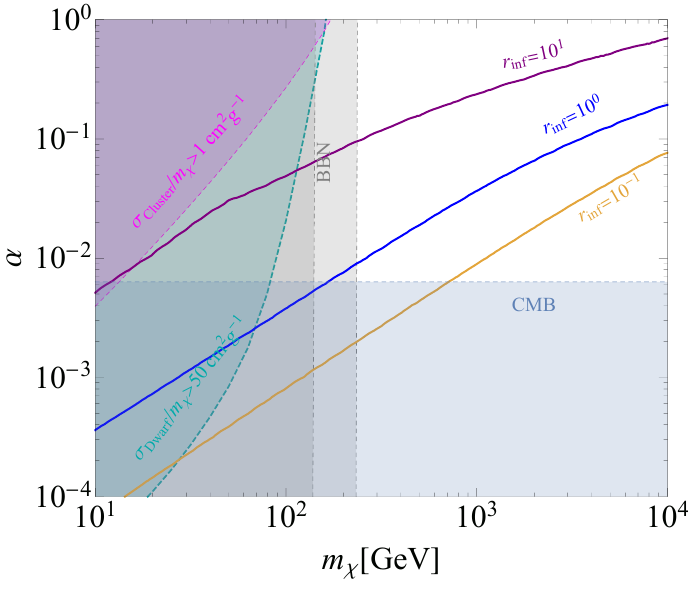
Figure 6 . Same as figure 5, but for the blind spot, i.e. A κ = − 3 κm χ